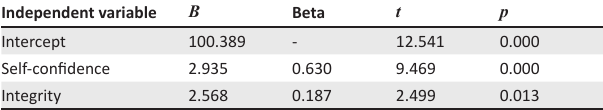
TABLE 5: Results of multiple regression with psychological climate scale as a dependent variable and authentic leadership subscales as independent variables .